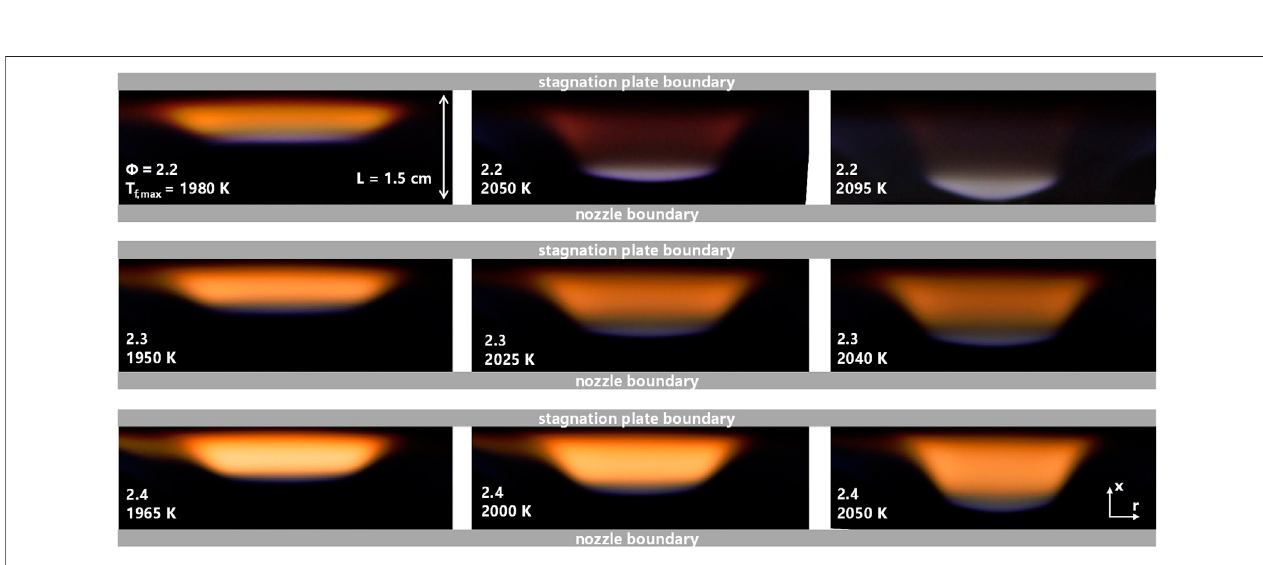
FIGURE 2 | Images for the series of fl ames currently